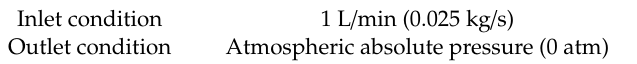
Table 2. Boundary conditions for numerical analysis.